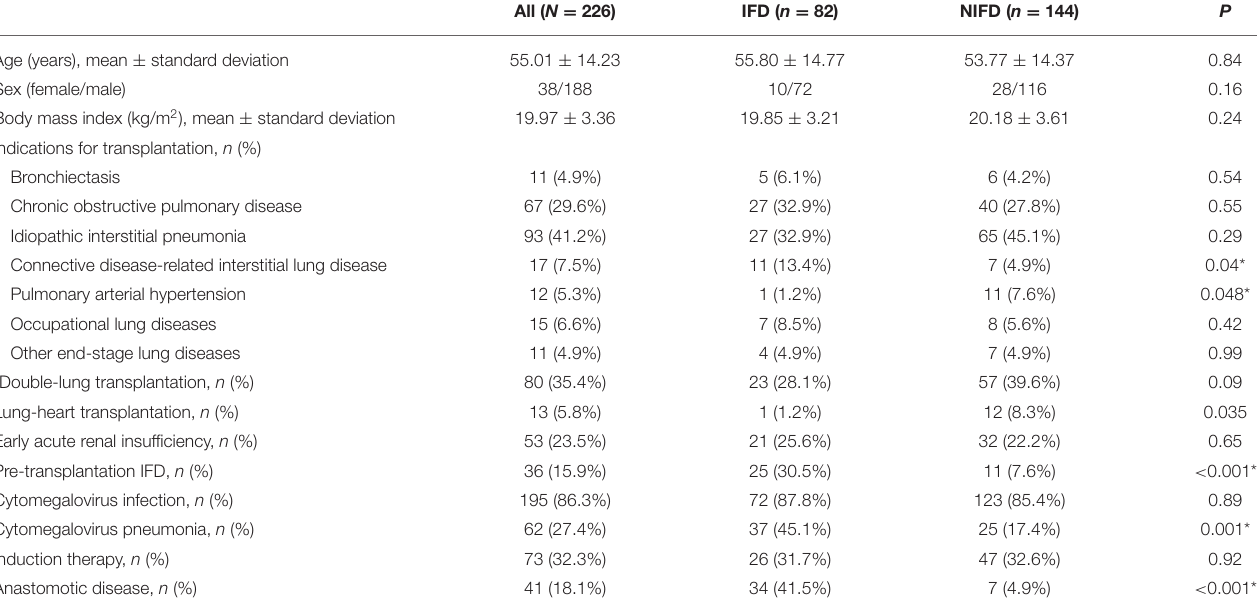
All ( N = 226) IFD ( n = 82)